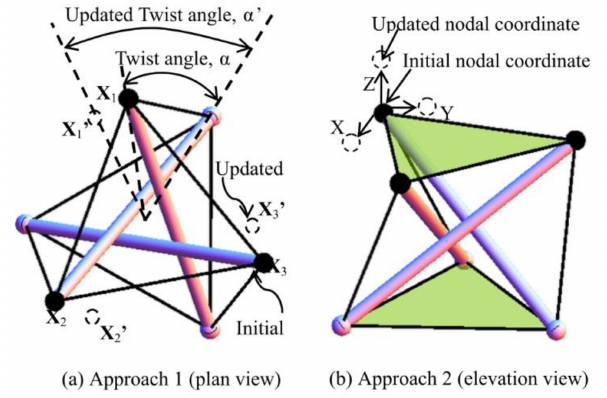
Figure 10. Methods used to generate trial configurations of spine biotensegrity model: ( a ) approach one and ( b ) approach